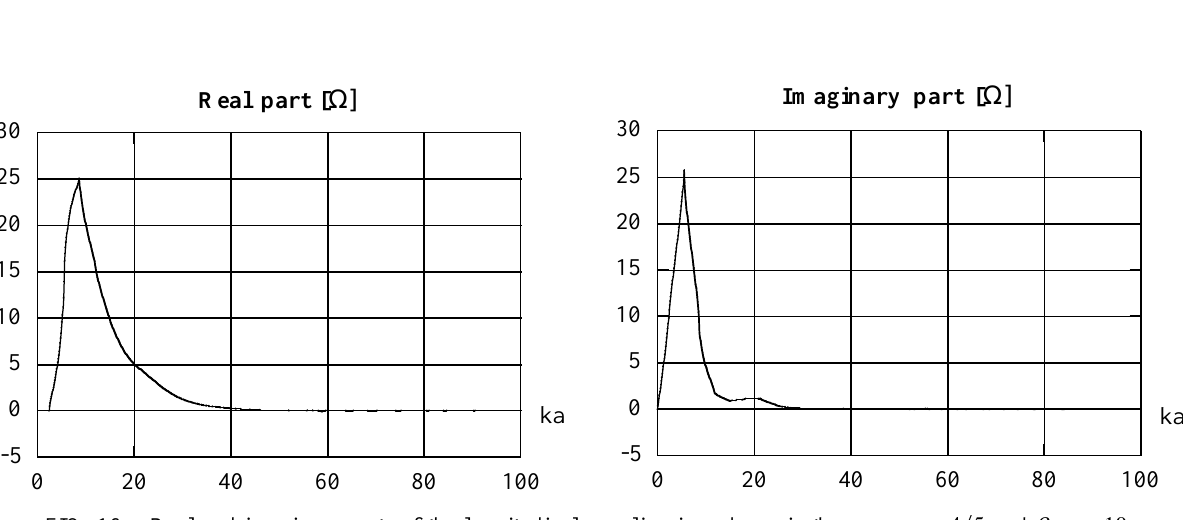
FIG. 16. Real and imaginary parts of the longitudinal coupling impedance in the case (cid:119) (cid:173) (cid:52) (cid:121) (cid:53) and bg (cid:173) (cid:49)(cid:48) .